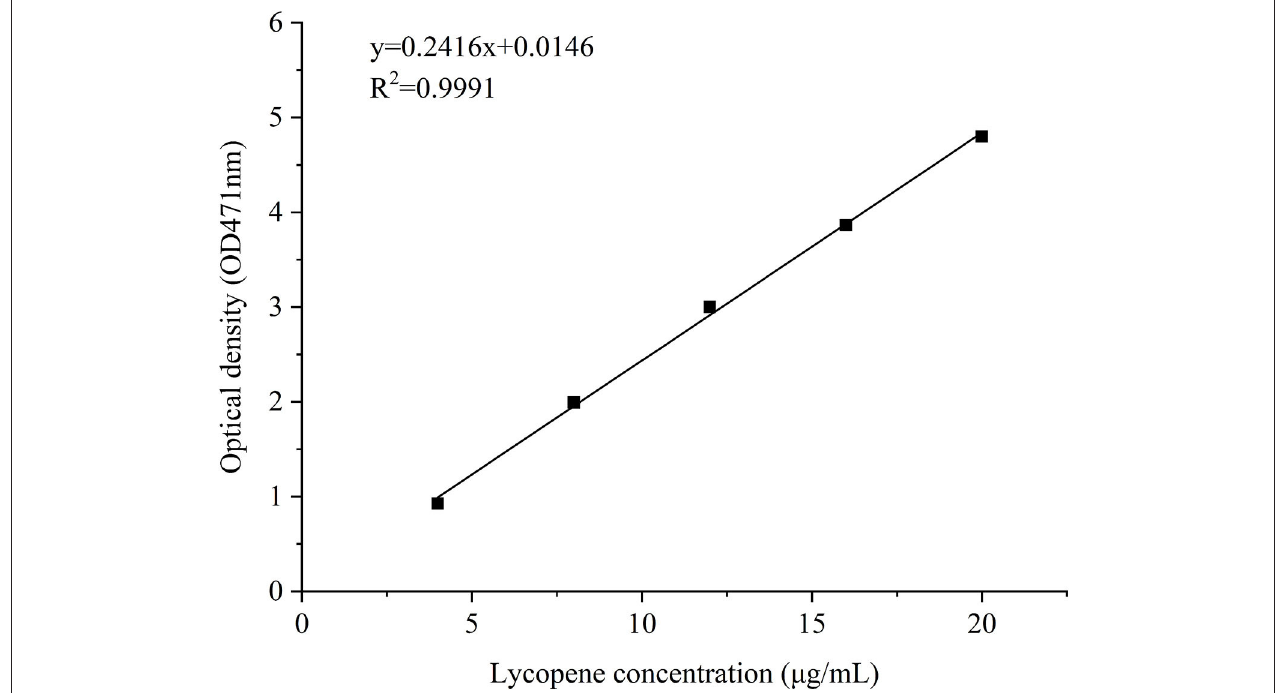
FIGURE 2 | A standard curve of free lycopene.